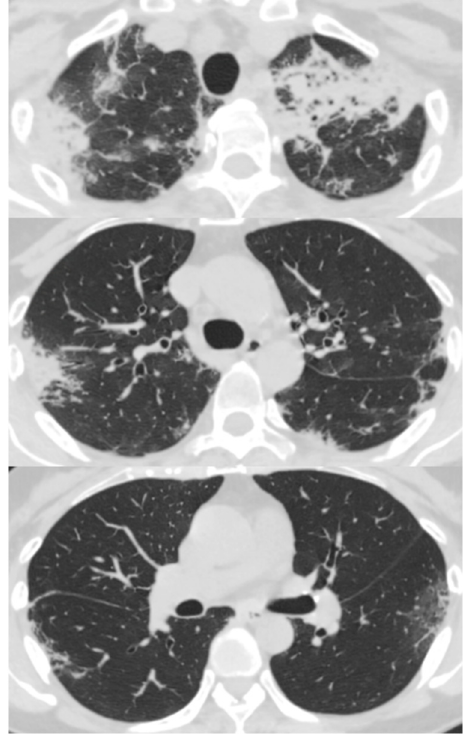
Figure 2. Chest computed tomography scan of 55-year-old woman with fever and dyspnea showed extensive ground-glass opacity in the left lung with contractile changes. Non-regional consolidation was scattered in the peripheral upper and middle lobes of her right lung.